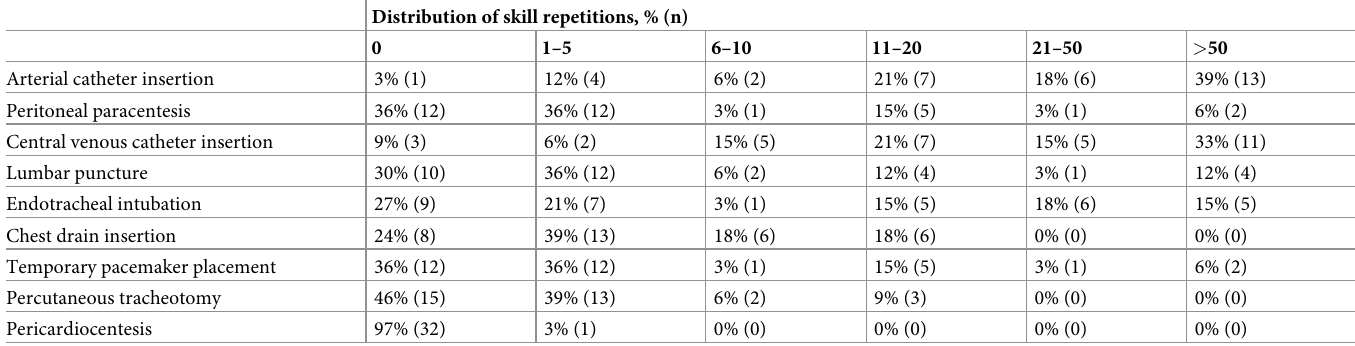
Table 3. Number of skill repetitions performed by residents.